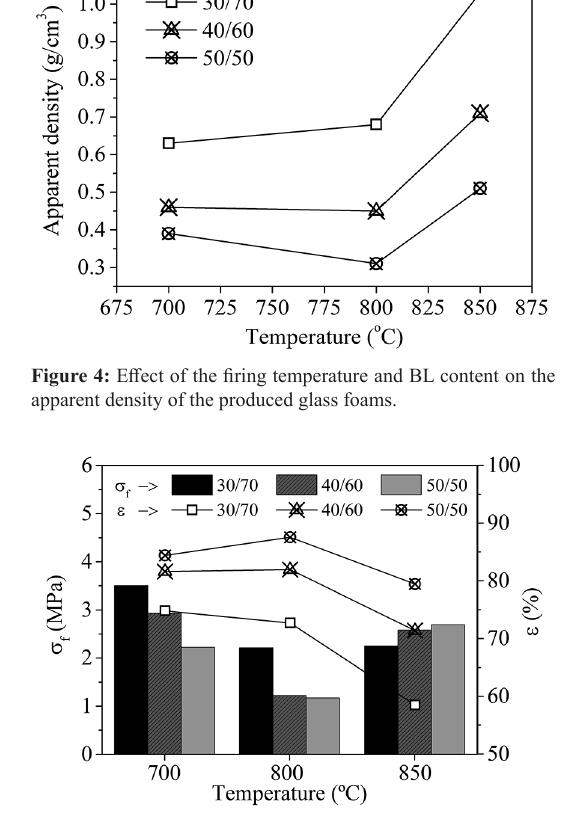
Figura 5: Effect of the firing temperature on the mechanical strength (σ ) and porosity (ε) of the produced glass foams for different f compositions